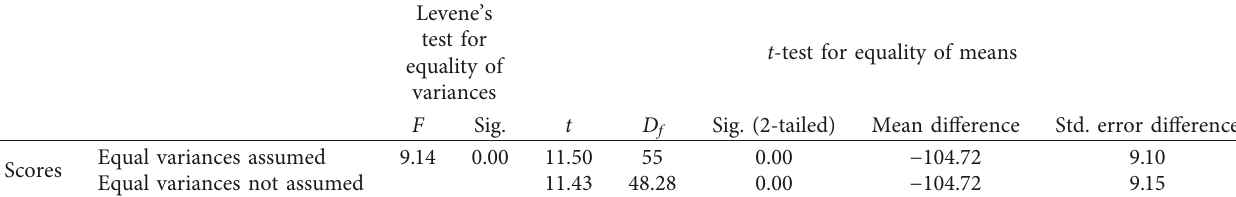
Table 8: Inferential statistics (motivation post-test of both